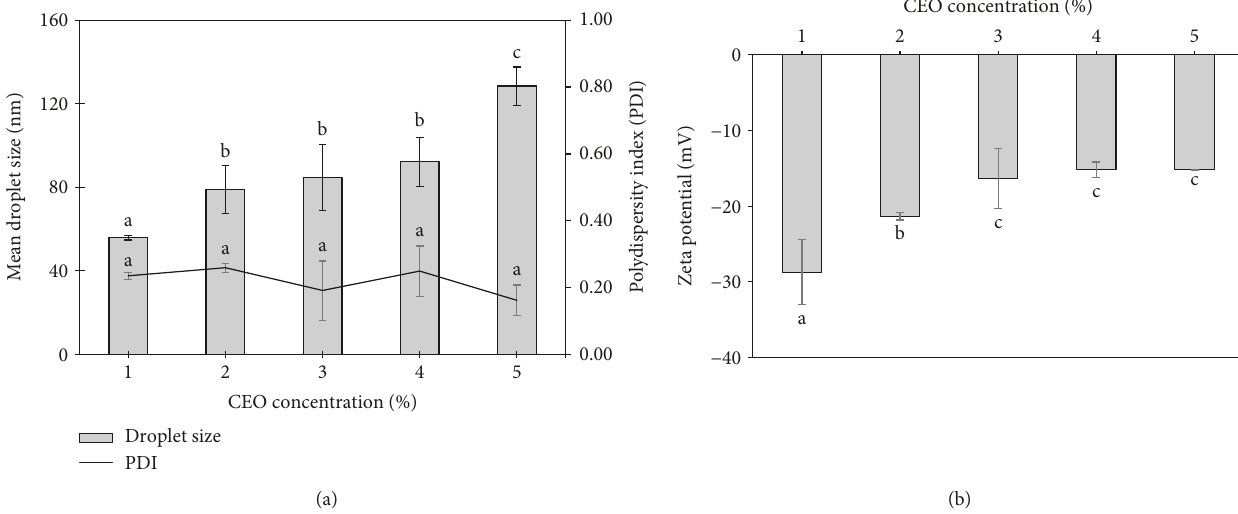
Figure 1: E ff ect of cinnamon essential oil (CEO) concentration on the (a) mean droplet size and PDI and (b) zeta potential of nanoemulsions (NEs). Di ff erent letters indicate a signi fi cant di ff erence at p < 0 05 by the ANOVA test. Error bars represent standard deviation ( n = 3 ).